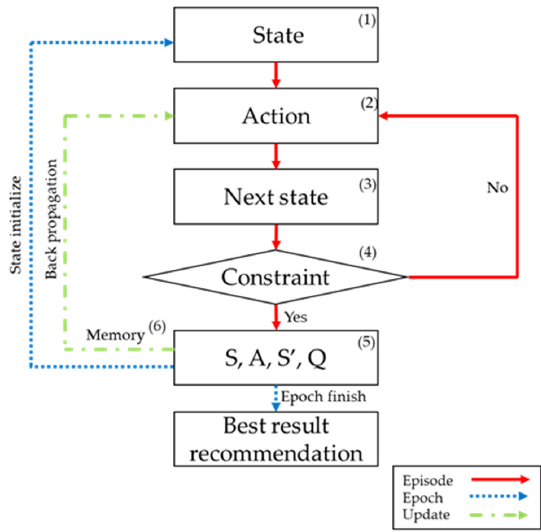
Figure 11. Deep RL algorithm procedure.